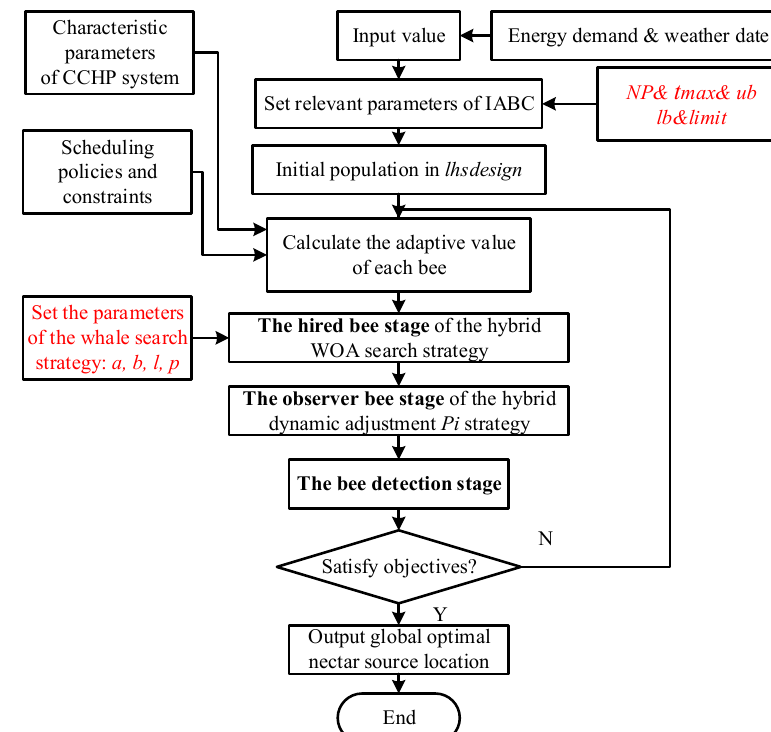
Figure 4. Optimization method based on the IABC algorithm.